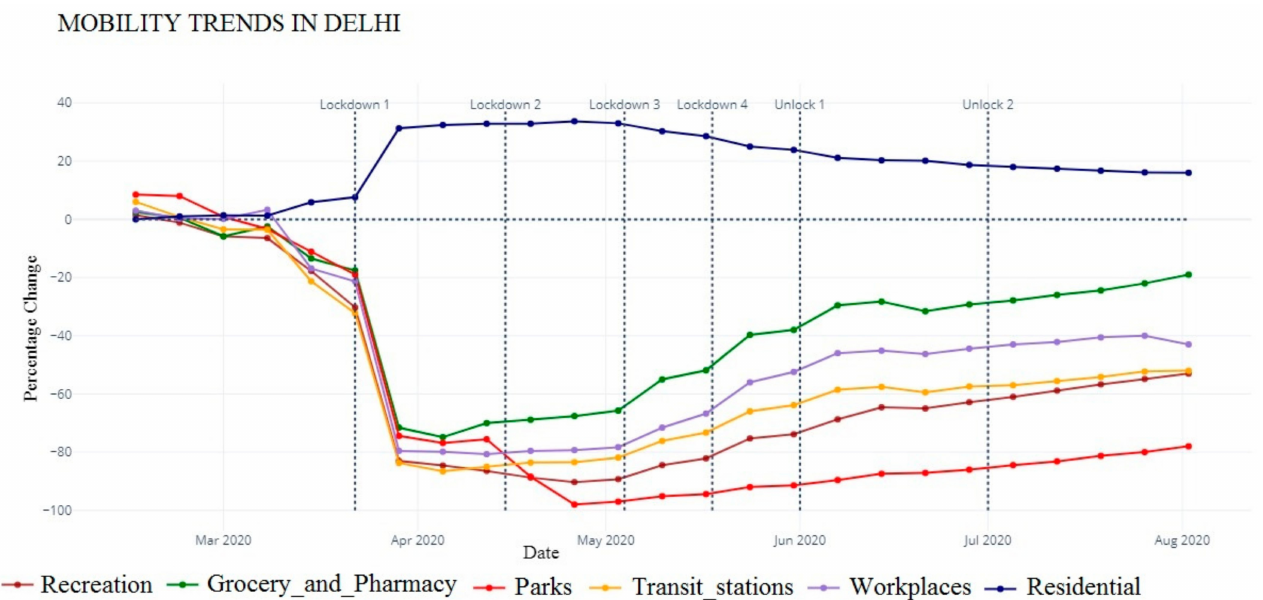
Figure 1. Mobility Trends in Delhi, percentage change in comparison to pre-COVID-19